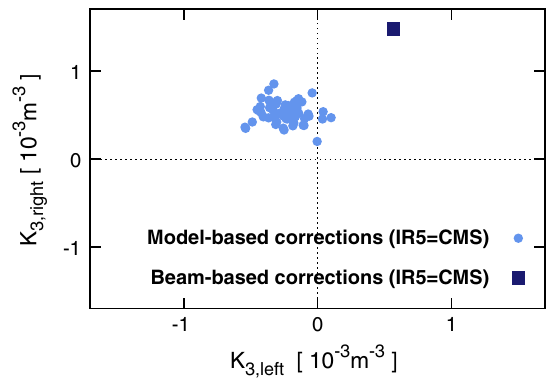
FIG. 15. Beam-based corrections for the normal sextupole errors applied in the CMS (IR5) insertion, compared to the expected corrections based upon magnetic measurements. Sixty instances of the model-based corrections are shown, correspond- ing to the uncertainty in the magnetic measurements.